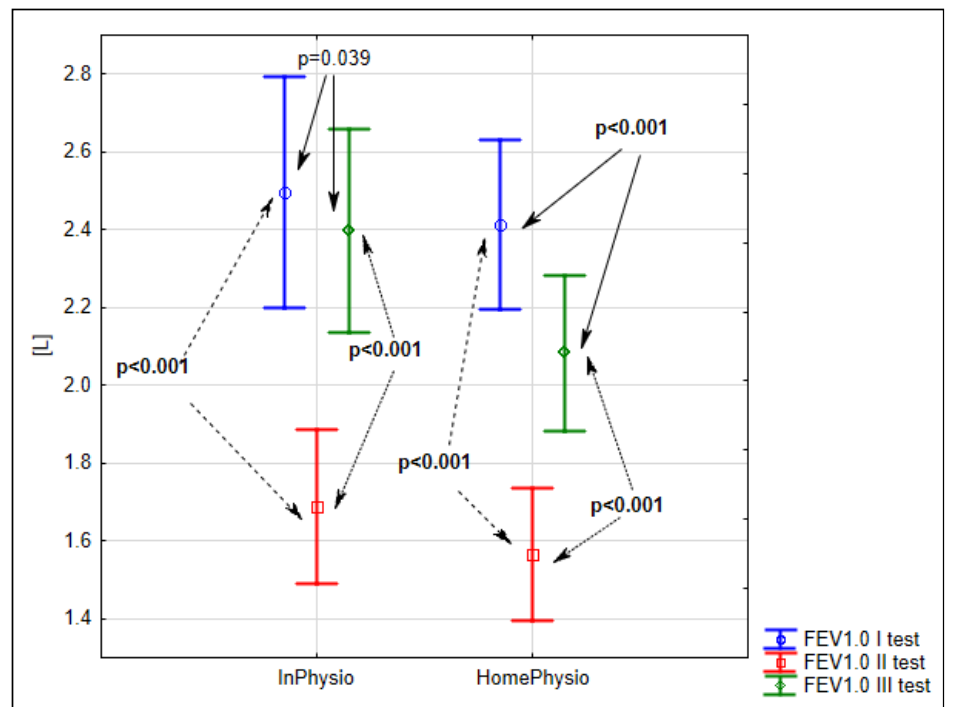
Figure 2. Evaluation of mean FEV 1.0 before surgery (S1), five (S2) and 25–30 days after surgery (S3) in the InPhysio and HomePhysio groups.